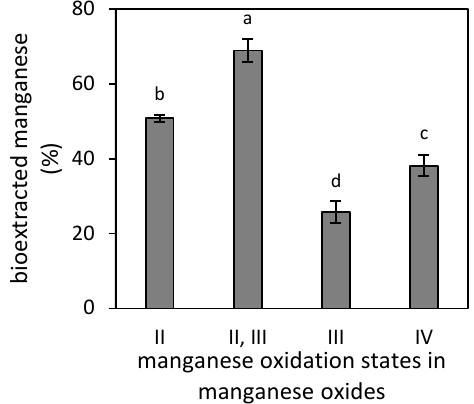
Figure 3. Bioextraction of manganese from its oxides (MnO, MnO · Mn 2 O 3 , Mn 2 O 3 and MnO 2 ) by microscopic filamentous fungus Aspergillus niger after a 21-day cultivation (initial weigh of each oxide was 0.25 g in 50 mL of culture medium; the extraction efficiencies were compared for all treatments via two-tail t-test at the 0.01 significance level).